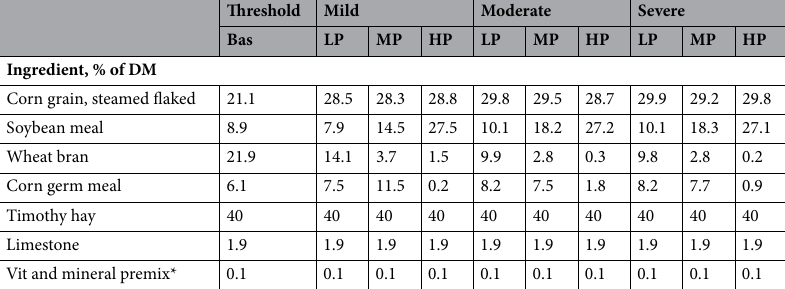
Table 1. Ingredient composition of experimental diets. *The premix contained (% as-is basis): trace mineral mix, 0.86; MgO (56% Mg), 8.0; NaCl, 6.4; vitamin ADE premix, 37.2; selenium premix, 0.07; and dry corn distillers grains with soluble, 45.7%; Ca, 12.1%; P, 0.41%; Mg, 4.59%; K, 0.44%; S, 0.39%; Se, 6.91 mg/kg; Cu, 383 mg/kg; Zn, 884 mg/kg; Fe, 216 mg/kg, vitamin A, 300,000 IU/kg, vitamin D, 85,000 IU/ kg and vitamin E, 2,300 IU/kg. THI = Temperature humidity index, THI = (1.8 × Tdb + 32) – [(0.55 – 0.0055 × RH) × (1.8 × Tdb − 26.8). Threshold = THI 70 to 73, Mild = THI 74 to 76, Moderate = THI 81 to 83, Severe = THI 89 to 91. LP = Low protein (12.5%), MP = Medium protein (15%), HP = High protein (17.5%).